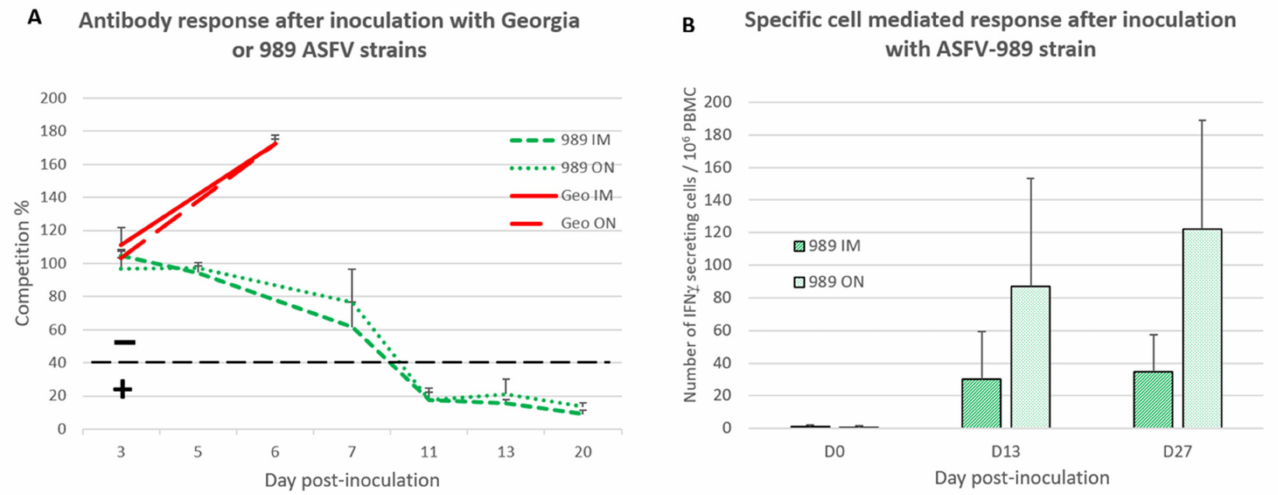
Figure 5. Development of the ASFV-specific immune response after ASFV-989 or Georgia strain inoculation. ( A ) Detection of ASFV-specific antibodies (competition ELISA) after Georgia or ASFV-989 strain inoculation (time in days post-inoculation). The dotted line indicates the positivity threshold of ELISA test. “–“ indicates seronegative samples, “+” indicates seropositive ones. 989 IM—group